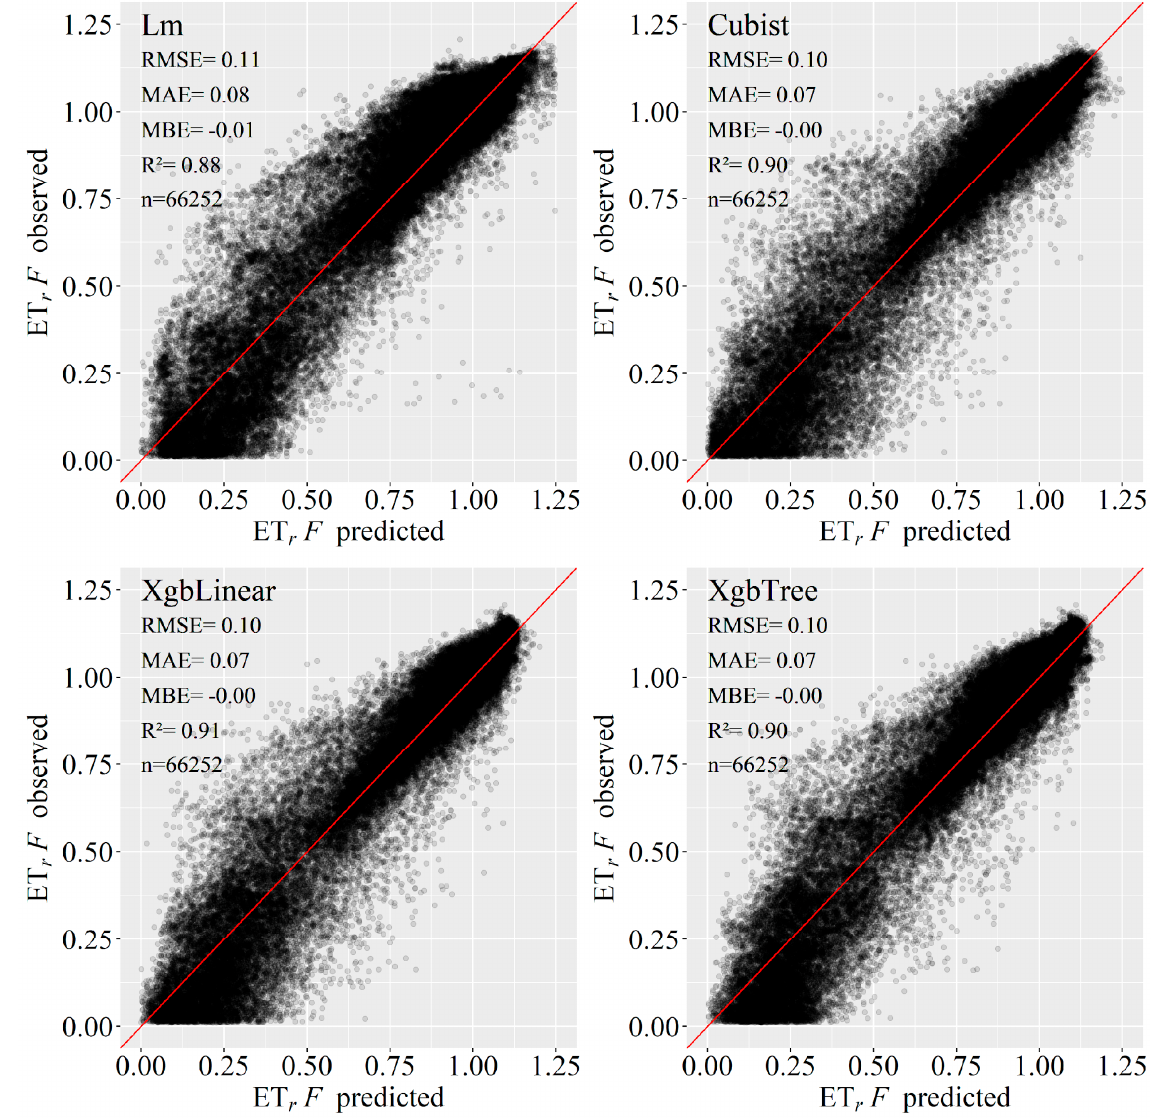
Figure 7. Statistical results of the test of approach 2.